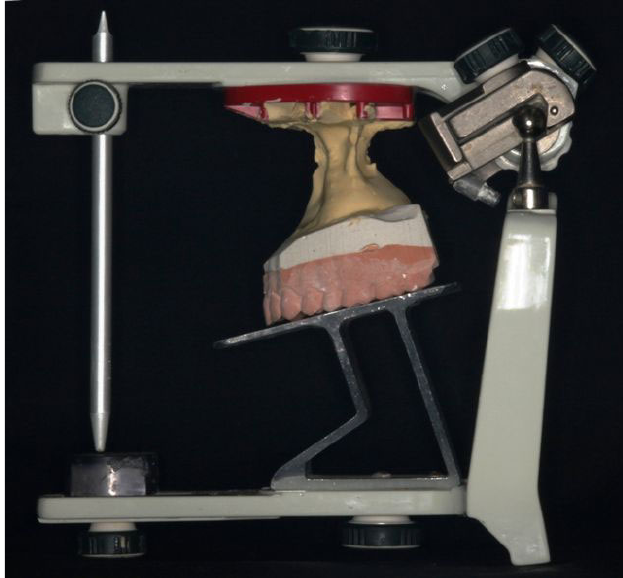
Fig. 3. Lateral view of the maxillary model of the control group mounted in a 13 degrees